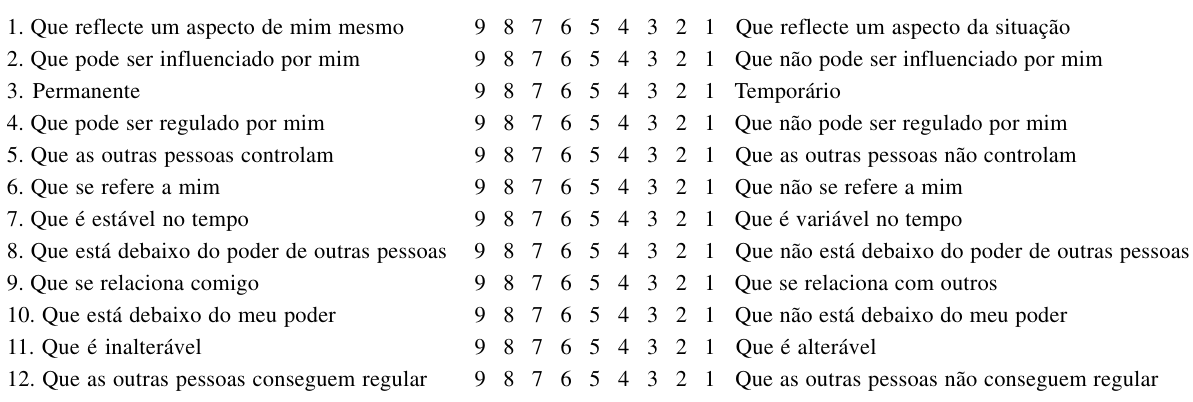
Figura 2. Avaliação das causas do melhor e do pior resultado. pontos. A Figura 2 descreve a estrutura essencial da escala utilizada. Referindo-se ao seu melhor e pior resultado de sempre e utilizando a consigne “A causa é (ou as causas são) algo:”, os atletas respondiam ao questionário presente na Figura